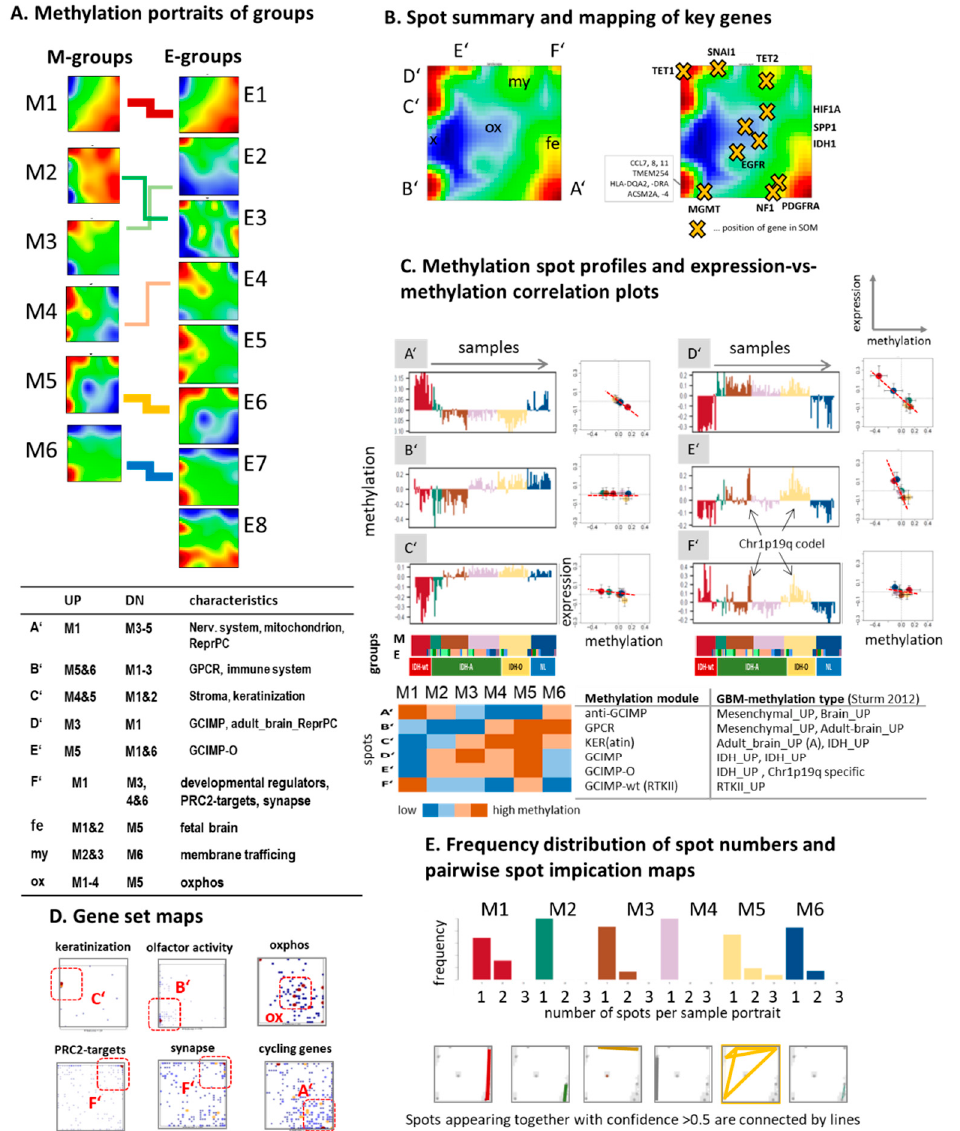
Figure 4. Cartography of the LGG methylome: ( A )–( E ) subgroup portraits, spot summary map, spot profiles, and functions. See legend of Figure 3 for details. The heatmap in part C provides an overview about the methylation spot modules. They were named as follows: anti-GCIMP (spot A’), resembling the CpG-HypOmethylation module of IDH -mutated tumors (CHOP, [29]); GPCR -module (B’); KER-module (C’, keratinization); GCIMP module (D’); GCIMP with specific hypermethylation of IDH -O (GCIMP-O, E’); and hypermethylation of IDH -wt, particularly of the RTK II type (GCIMP-wt, F’) [9]. The spots enrich selected GBM methylation signatures according to [9], which were taken from [29].